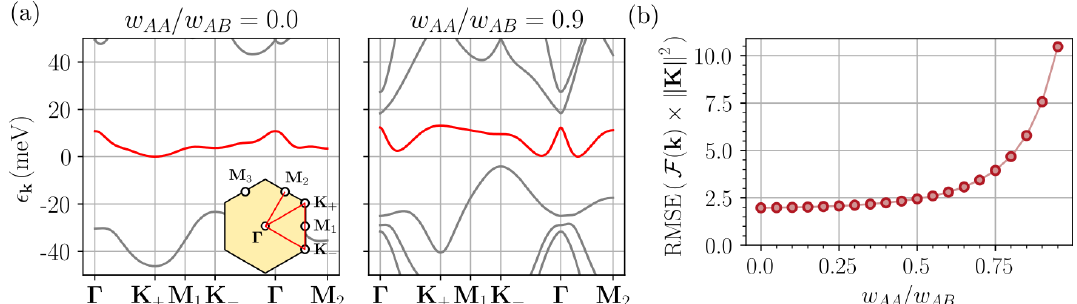
Figure 2: (a) Non-interacting band structure of the ( τ “ ´ valley) TDBG continuum model near the charge neutral Fermi energy and (b) inhomogeneity of the conduction band Berry curvature [ defined in Eq. (14) ] as a function of the moiré relaxation ratio { w w , see App. B for parameters used. The red bands in (a) have Chern number AA AB | C | “ 2. Their energetic minimum is shifted to zero for illustration